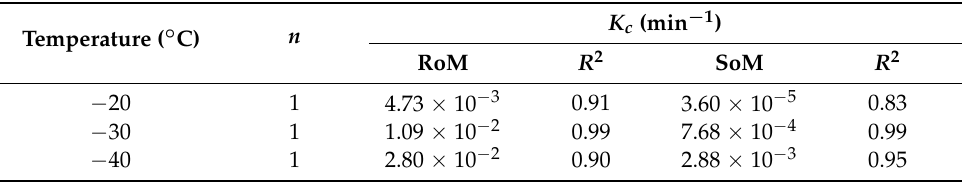
Table 7. Variation of crystallization rate constant, K c , with temperature recalculated using an Avrami exponent, n , of 1.